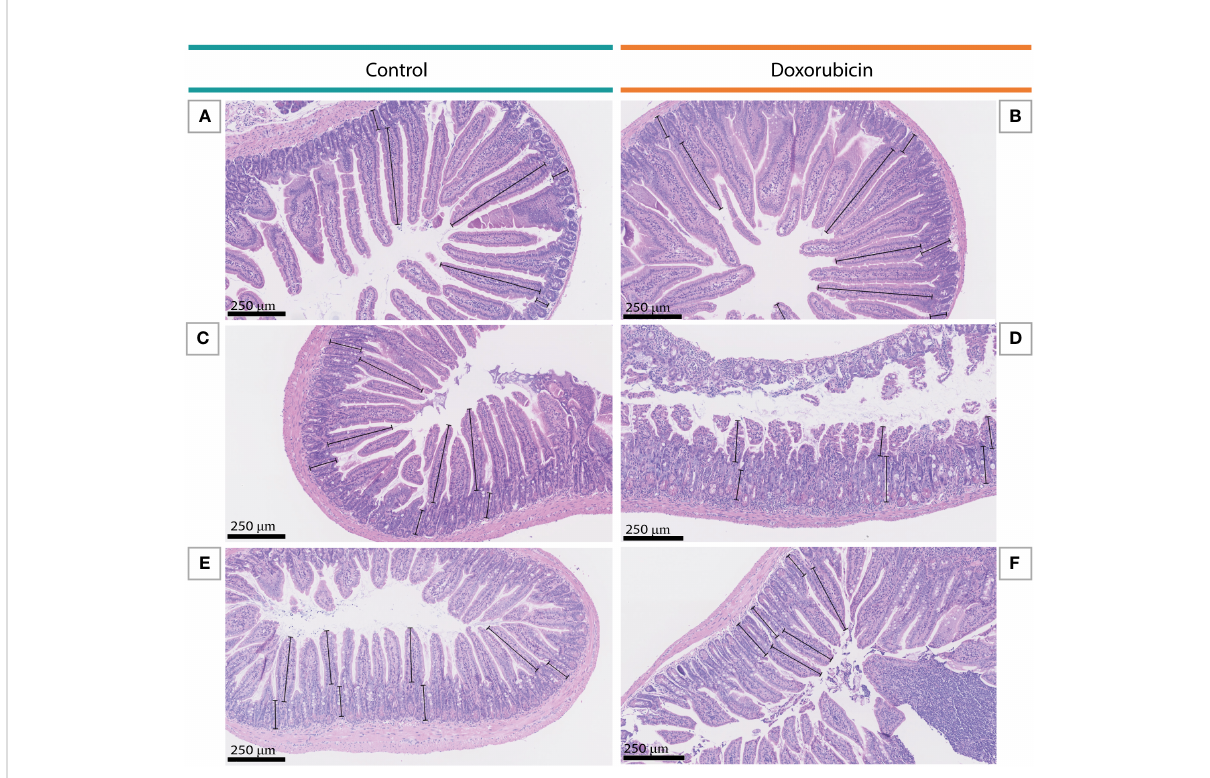
FIGURE 5 Examples of villus and crypt measurements in the small intestine on day 3. (A, B) Duodenal tissue from a mouse in the control group and a mouse in the doxorubicin group, respectively. (C, D) Jejunal tissue from a mouse in the control group and a mouse in the doxorubicin group, respectively. (E, F) Ileal tissue from a mouse in the control group and a mouse in the doxorubicin group,